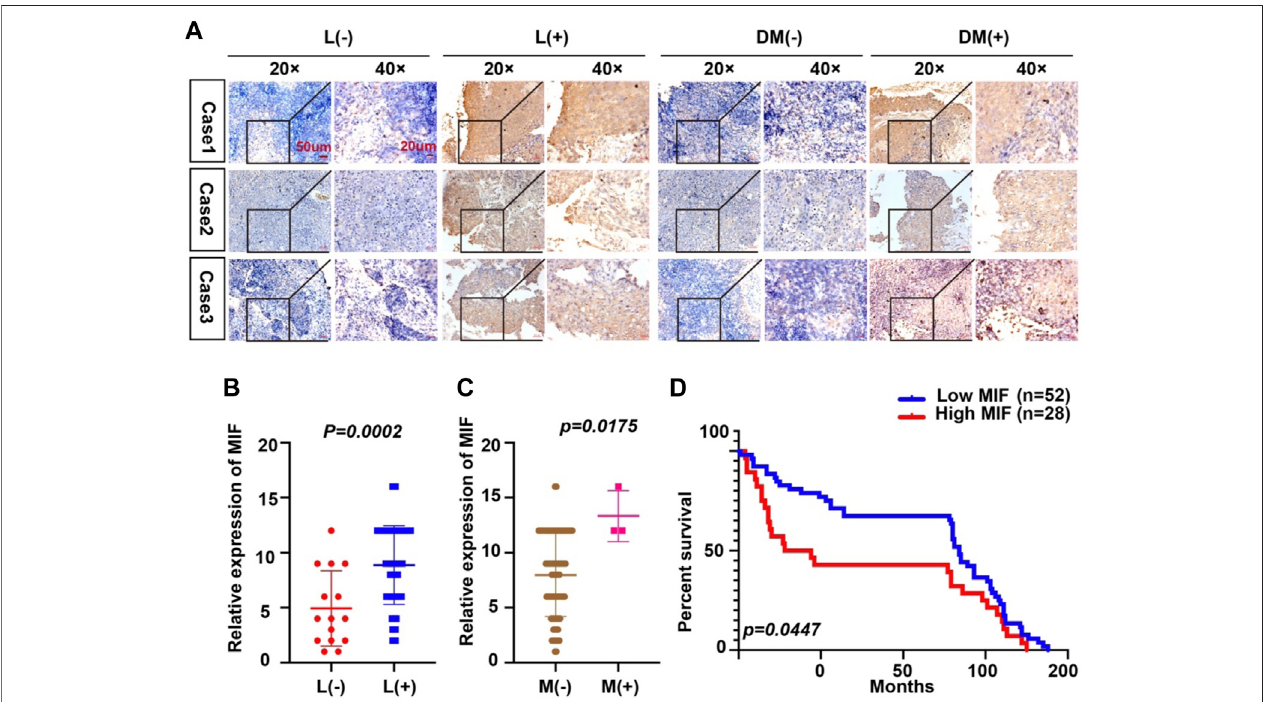
FIGURE 2 | Overexpression of MIF is more prominent in NPC patients with metastasis. (A) Representative IHC images of MIF staining in tissues collected without lymphnodemetastasis,withlymphnodemetastasis,withoutdistantmetastasis,andwithdistantmetastasisspecimensfromNPCpatients. (B – D) Statisticalanalysesof theassociationofMIFexpressionwithlymphnodemetastasis,distantmetastasisandprognosisandKaplan-Meieranalysis.Allgraphsshowthemean ± SEMofatleast three independent experiments. * p < 0.05, ** p < 0.01, *** p < 0.001.